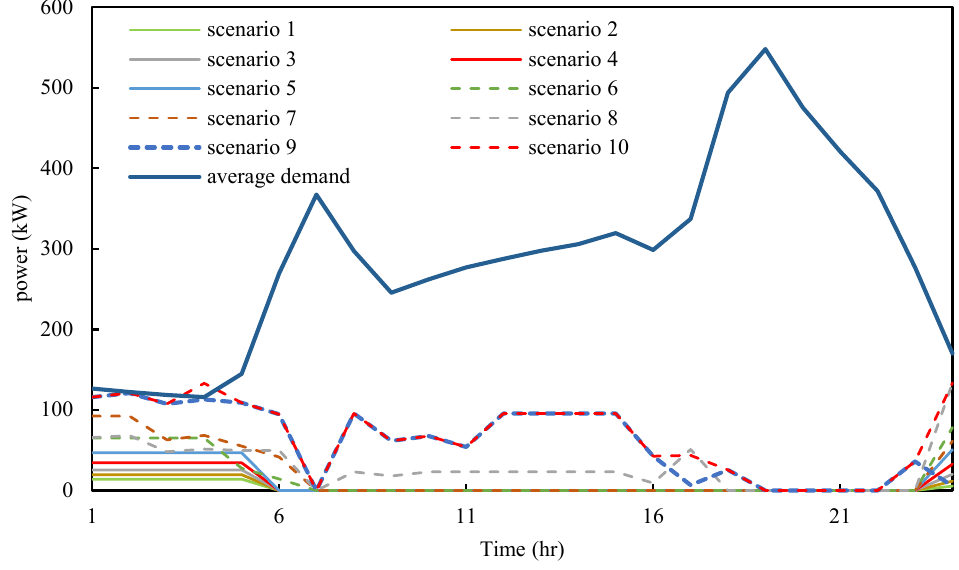
Figure 16. Average charging power per stochastic scenario.